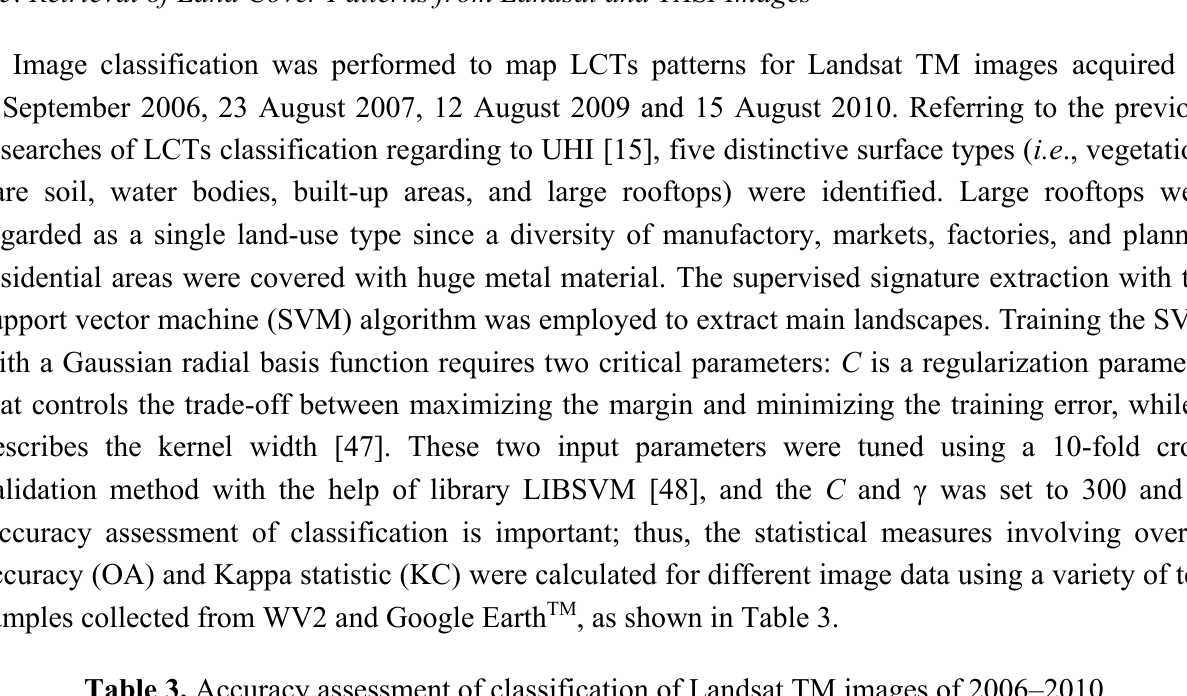
Table 3. Accuracy assessment of classification of Landsat TM images of 2006–2010.